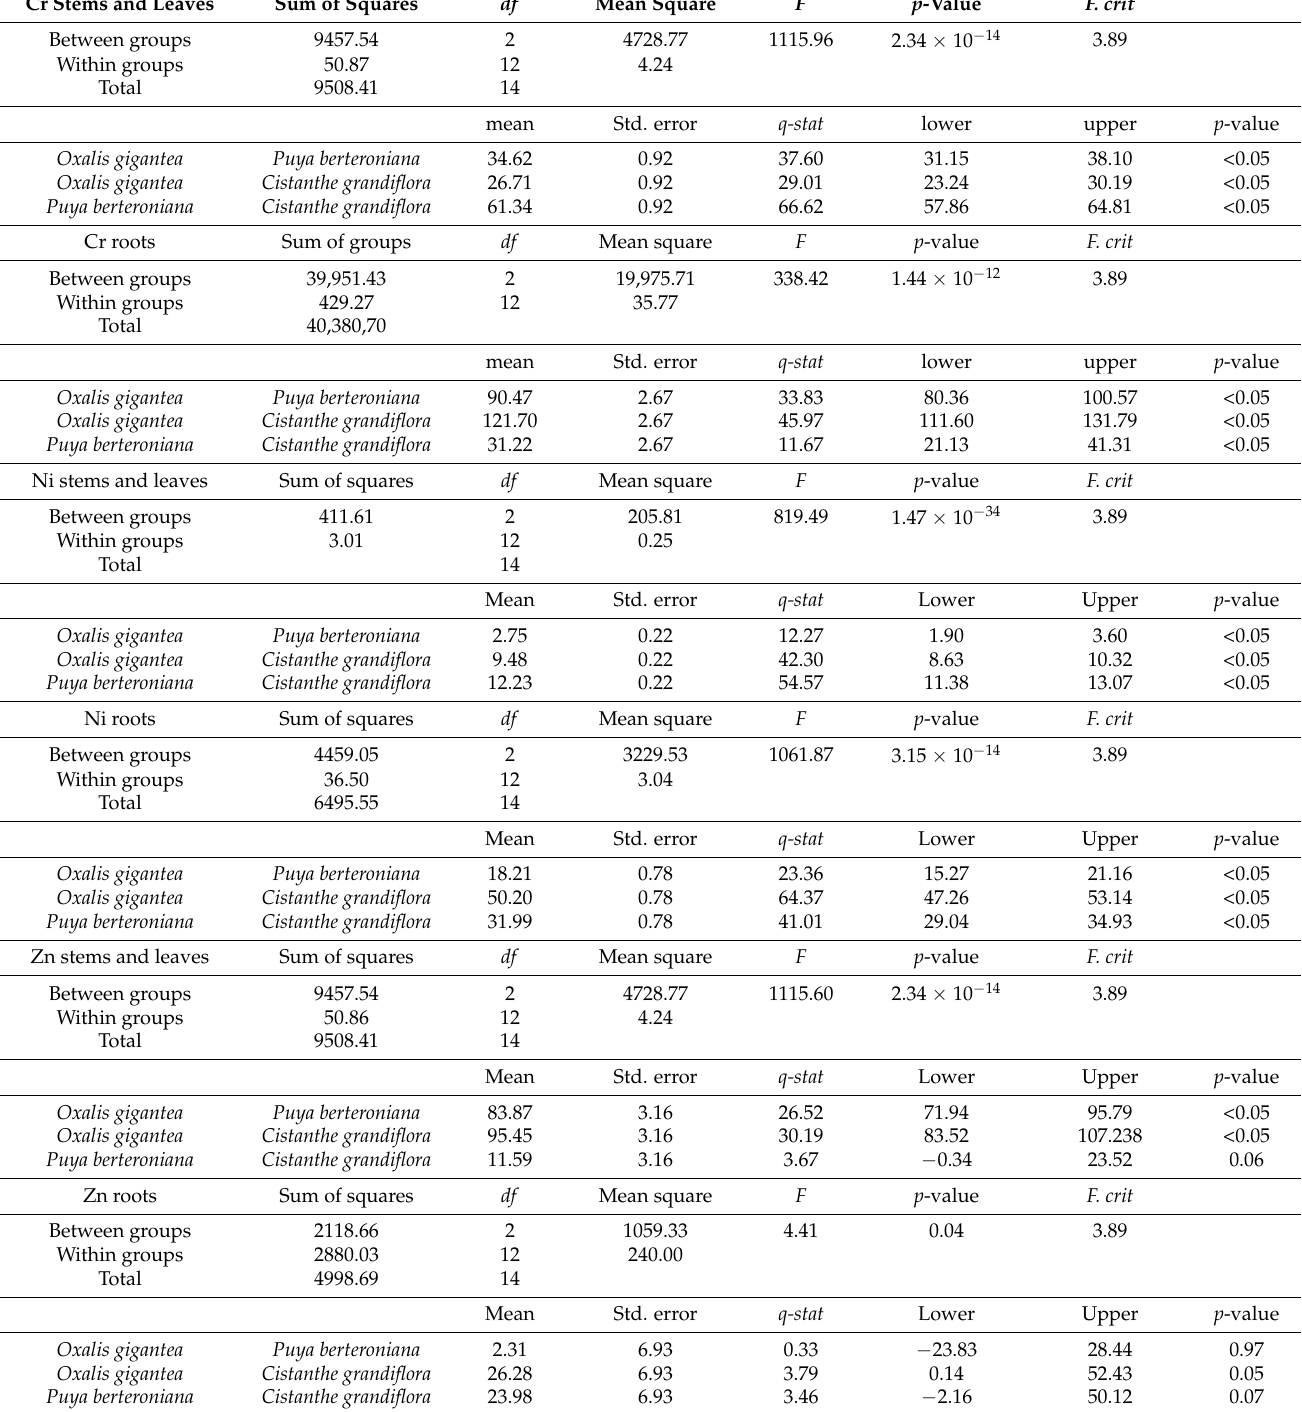
Table 5. ANOVA and Tukey test results for Cr, Ni, and